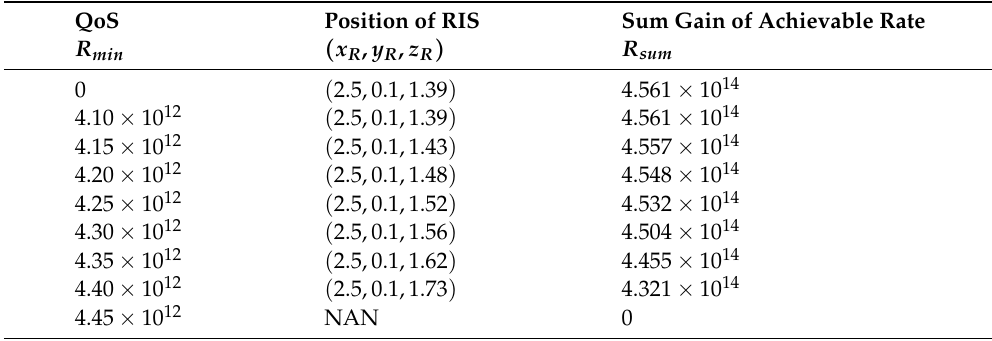
Table 2. Achievable Rate Performance versus different R min